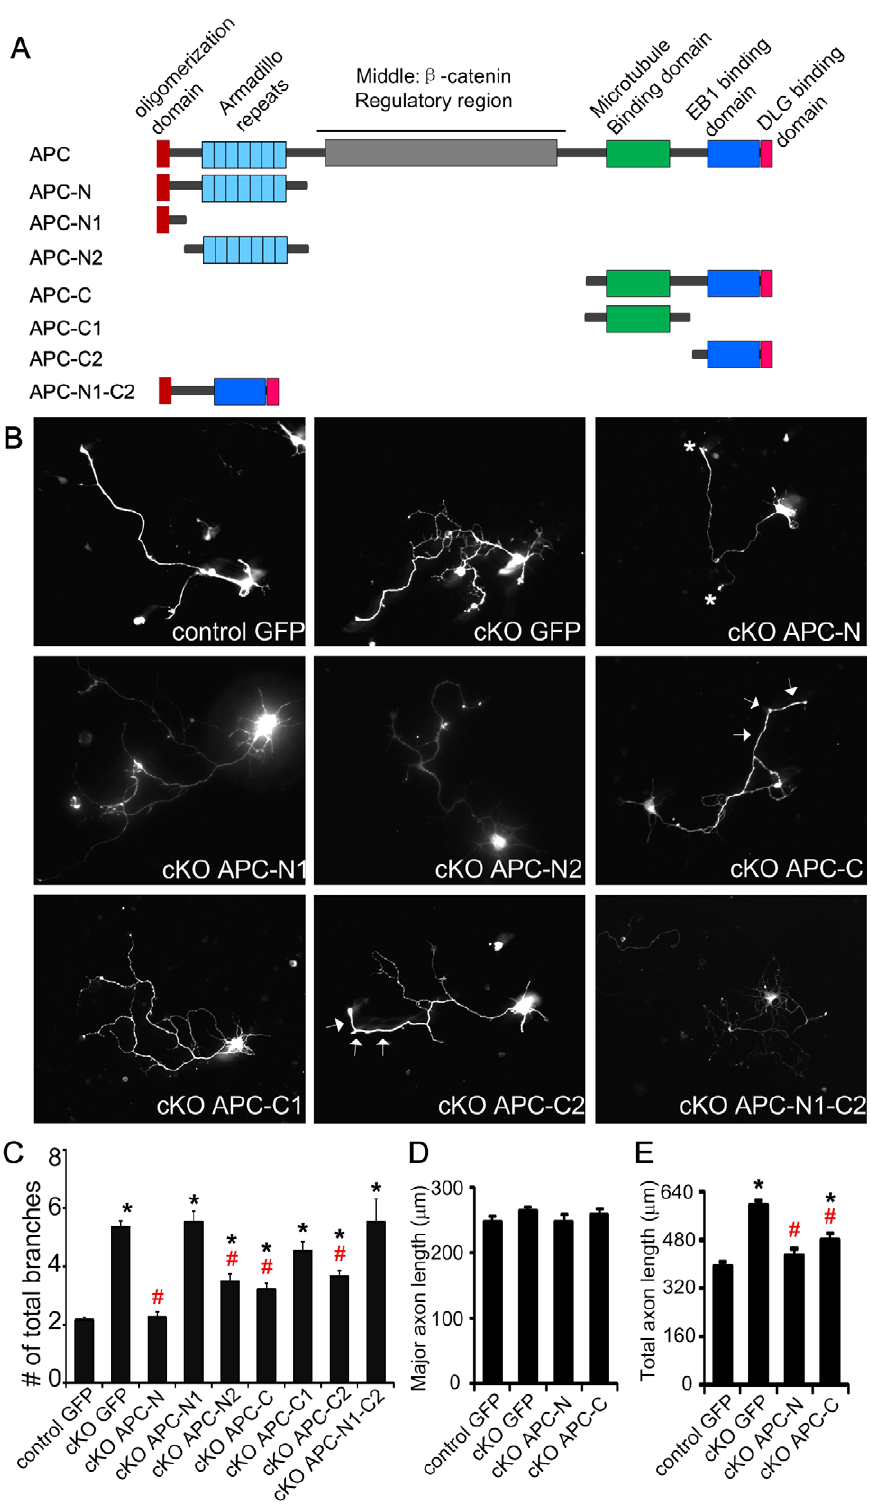
Figure 5. N-terminus of APC rescues branching phenotype in APC deleted neurons. (A) Schematic of full length APC and APC fragments used in this study. All truncation mutants were fused with GFP at the N-terminus. (B) Control cortical neurons expressing GFP alone and APC cKO cortical neurons expressing GFP alone or APC truncation mutants. Cortical neurons from E14.5–E15.5 embryos were dissociated, electroporated with GFP and the truncation mutants as indicated, and cultured for 4days in vitro . Representative images of axonal branching of neurons transfected with the indicated constructs are shown. Stars indicate the axon tip localization of APC-N. Arrows indicate the distal localization of APC-C and APC-C2. (C) Numbers of total axonal branches per neuron. (D) Average length of major axons and (E) total axon (including axon branches) length from neurons expressing GFP or APC truncation mutants as indicated. C, D, E: *: P , 0.01, when compared with control neurons expressing GFP alone. # : P , 0.01,